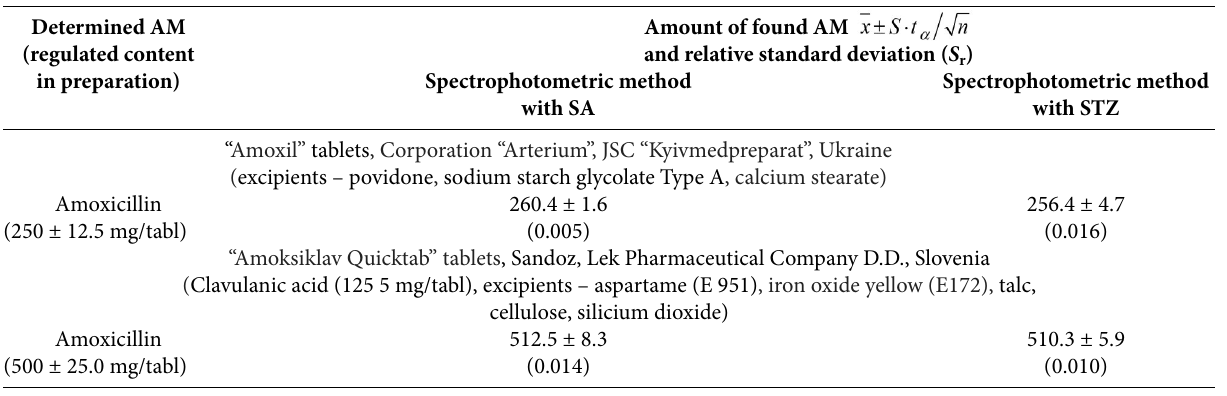
Table 6. Determination of AM in pharmaceuticals. С НСІ = 0.6 М, С SA = 4.5 ∙ 10 –4 М, C NaNO = 5.6 ∙ 10 –3 M,